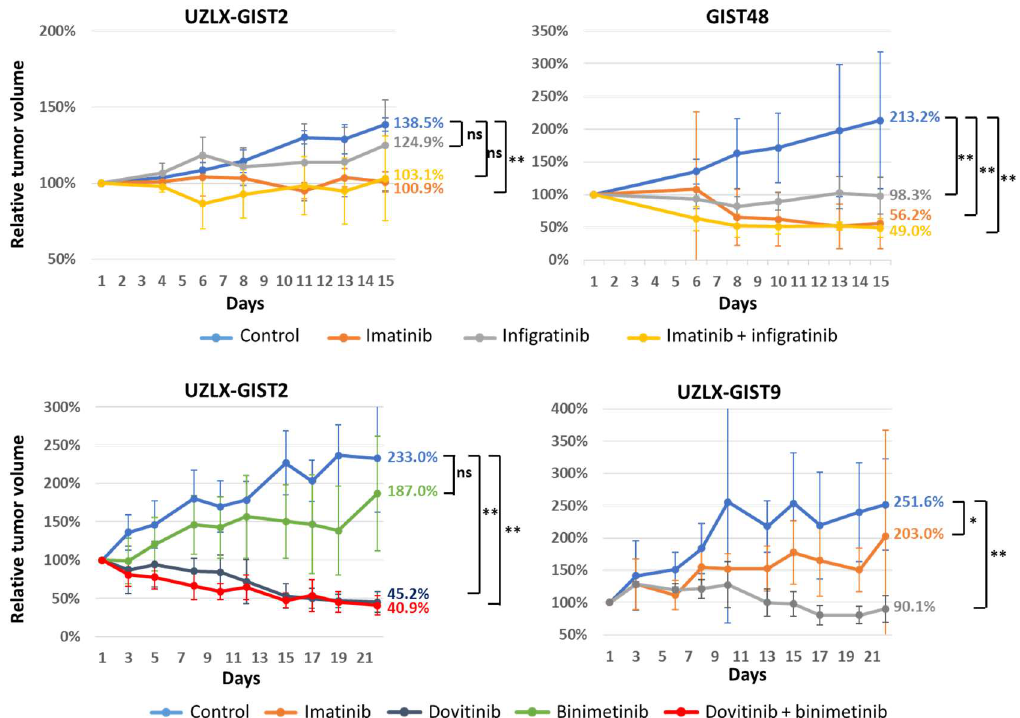
Figure 1. Evolution of tumor volume. Legend: Relative tumor volume evolution in the experiment testing infigratinib for two weeks and dovitinib for three weeks. The average values per were compared with control groups in the respective experiments, Mann–Whitney U test was performed to assess the difference between treatment versus respective control groups: ns—not statistically significant; * p < 0.05; ** p < 0.005.